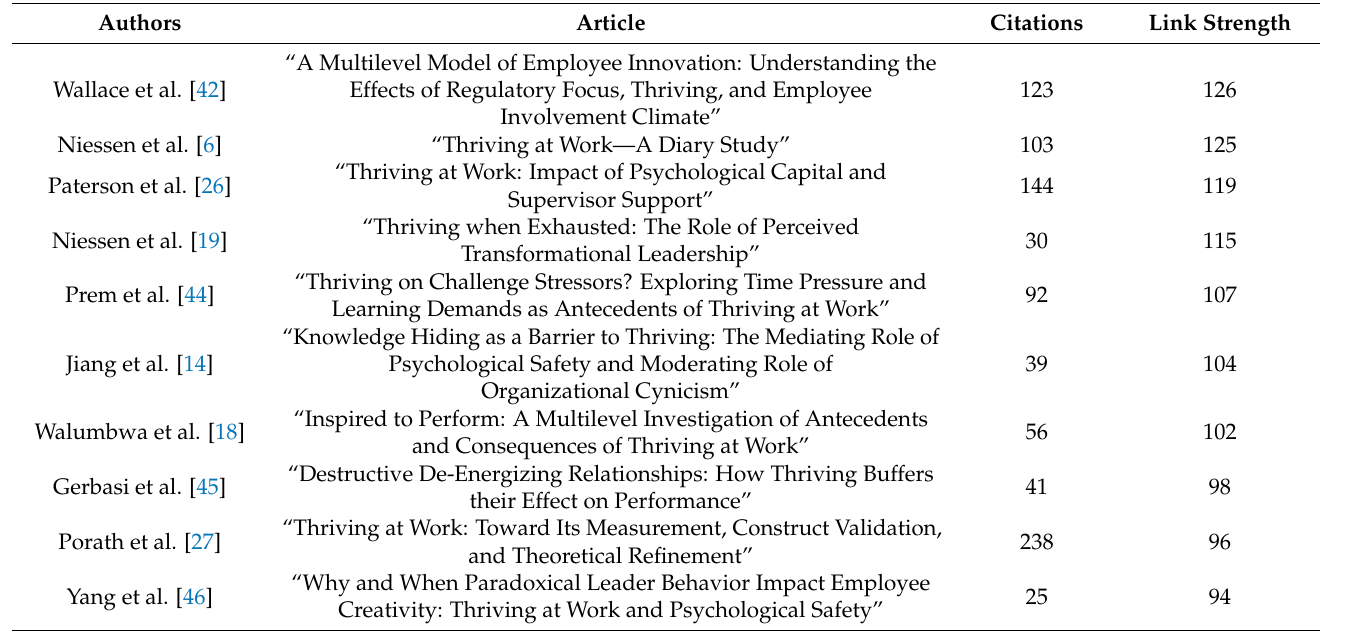
Table 8. Bibliographic coupling of articles.